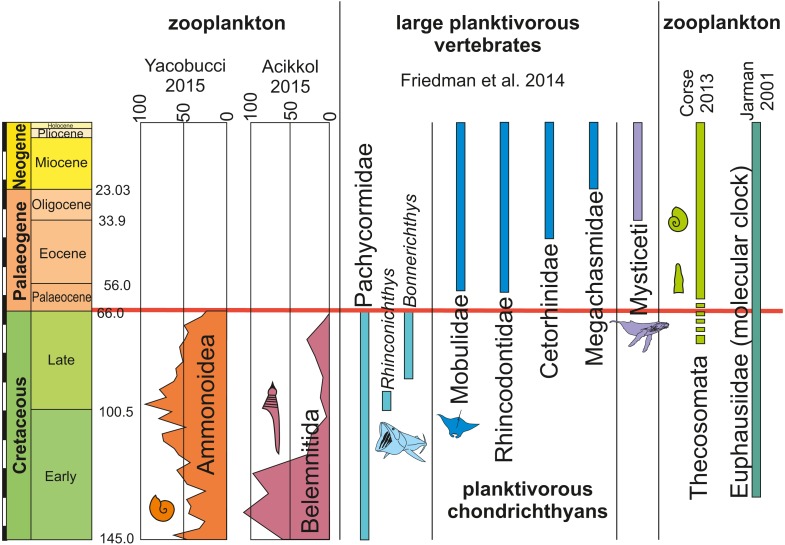
Occurrences, extinctions, originations and diversity changes in plankton and large planktotrophic suspension feeders from the Cretaceous to the Palaeogene (mass extinction marked by red bar).Ammonite and belemnite diversity show the number of species. Data from Friedman et al. (2010), Bristow, Ellison & Wood (1980), Corse et al. (2013), Yacobucci (2015) and Jarman (2001). Note the relative timing of extinctions of cephalopods with small planktonic juveniles and filter-feeding bony fish and rediations of holoplanktonic gastropods, krill as well as filter-feeding chondrichthyans and whales.